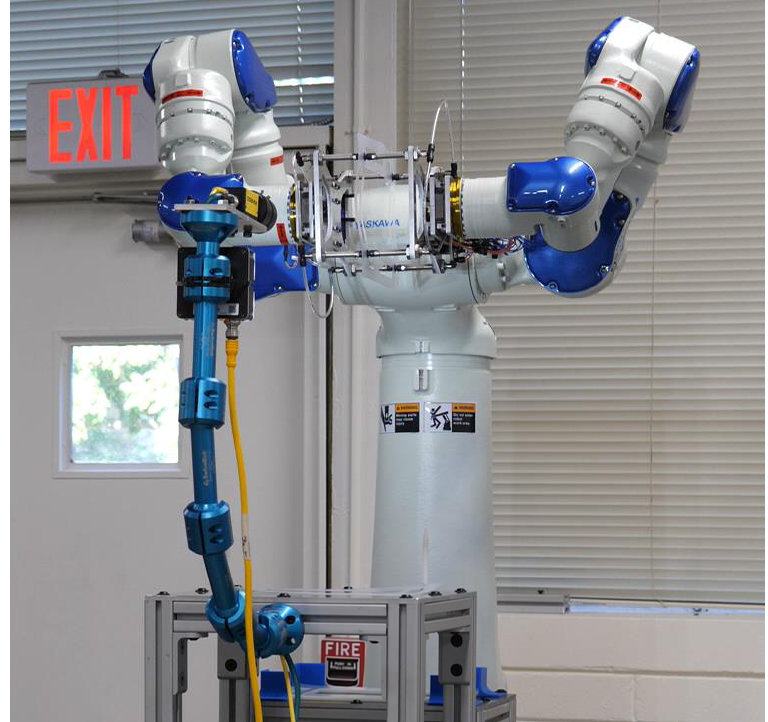
Figure 9. Robot hands operating in coordinated manipulation mode to flip the fuel cell component.